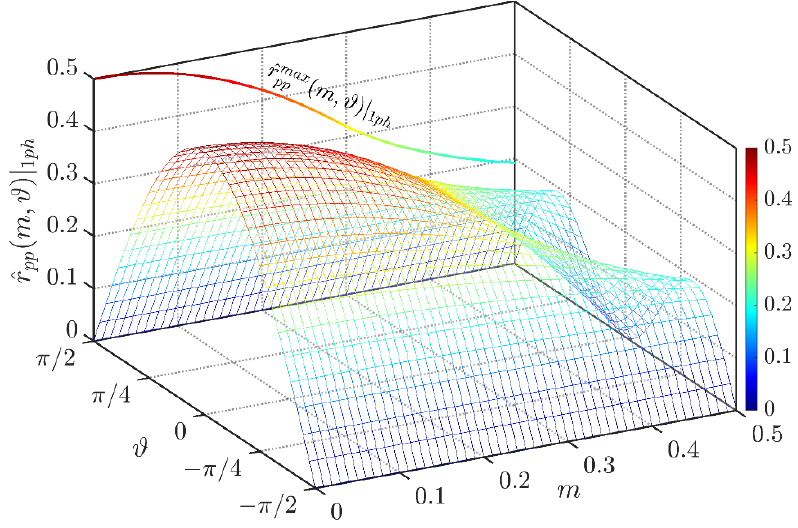
Figure 12. Normalized capacitors switching voltage ripple (ˆ r 1 and ˆ r 2 ) (blue traces), dc-link switching voltage ripple (ˆ r ) (red trace) and calculated envelopes (black traces) over a fundamental period for m = 0.4 ( a ) and m = 0.5 ( b ) in case of ϕ = 0 ◦ and unbalanced load (single-phase load).